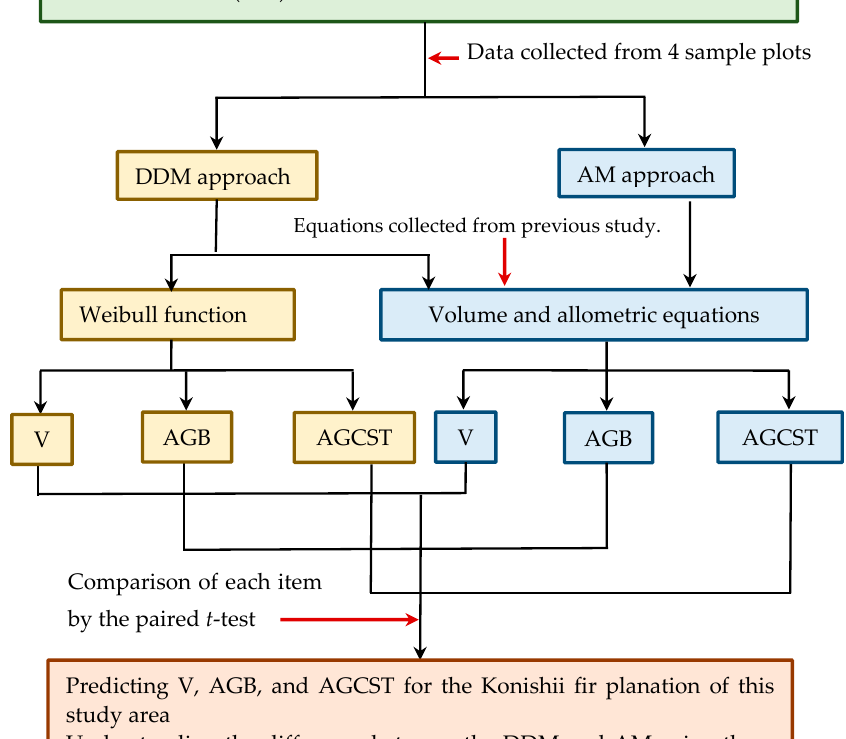
Figure 2. The flowchart of model application to predict stand volume, aboveground biomass accumulation, and carbon storage capacity of Konishii fir ( Cunninghamia konishii Hayata) plantation in central Taiwan.